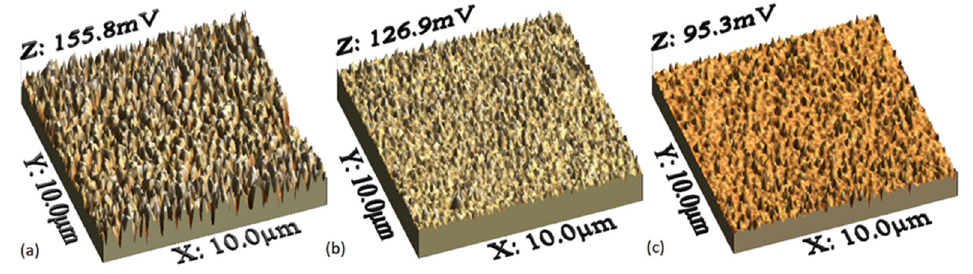
Figure 4. AFM images of ( a ) PEDOT:PSS-CoP, ( b ) PEDOT:PSS-CuP, and ( c ) PEDOT:PSS-PdP composites films. Table 2. RMS and bandgap for PEDOT:PSS-MP composite